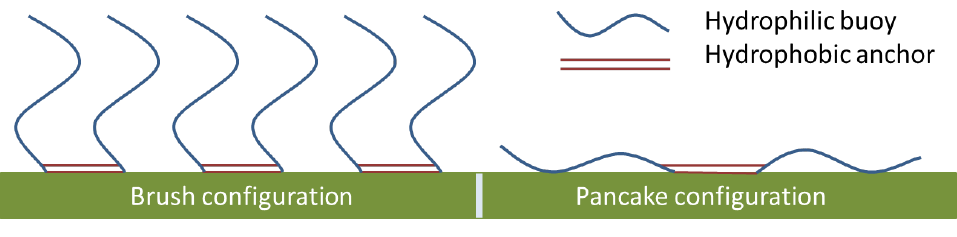
Figure 1. Schematic representation of the adsorption of a polyethylene oxide-polypropylene oxide-polyethylene oxide block co-polymer onto a hydrophobic and hydrophilic surface. Only in the brush configuration protein adsorption is prevented, and the wettability of the surface remains intact.